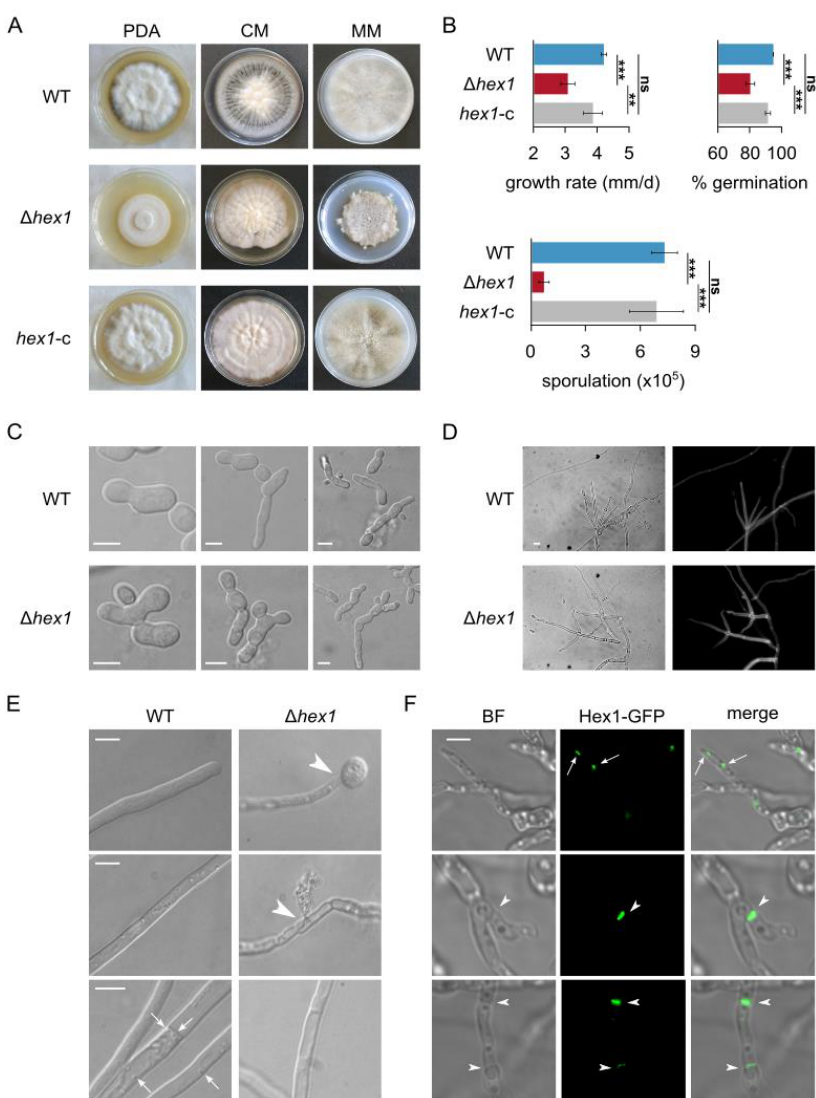
Figure 2. Morphological and physiological characterization of the V. dahliae ∆ hex1 strain. ( A ) Colony morphologies of the V. dahliae wild-type isolate (Ls.17), the deletion mutant ∆ hex1 , and the complemented strain hex1 -c, after growth for 25 days on PDA, CzD-CM, and MM. CM: CzD-CM. ( B ) Growth rate, ability of conidia to germinate, and abundance of conidial production of the three strains. All experiments were performed in triplicate, and 150 conidia were tested for germination per replicate. Bars: SD. Statistical significance of differences was tested by one-way ANOVA, followed by Tukey’s post hoc test (** p ≤ 0.01, *** p ≤ 0.001, ns: nonsignificant). ( C , D ) Microscopic characteristics of conidia ( C ; bars = 5 µ m) and hyphae ( D ; cell wall staining using calcofluor white M2R; bar = 10 µ m) of the wild-type and the ∆ hex1 strains. ( E ) Response of the wild-type and the ∆ hex1 strains to hypotonic shock by immersing their hyphae to distilled water. Arrowheads: hyphal burst and cytoplasmic leakage. Arrows: spherical vesicles, usually localized close to the septal wall, that were observed during live-cell imaging of the wild-type strain but were absent from ∆ hex1 . Bars = 10 µ m. ( F ) Subcellular localization of the Hex1-sGFP tagged protein in V. dahliae . Hex1 is localized either in small globular vesicles (presumably peroxisomes or Woronin bodies (WBs), indicated by arrows) or at the septal wall (arrowheads). Bar = 5 μM.